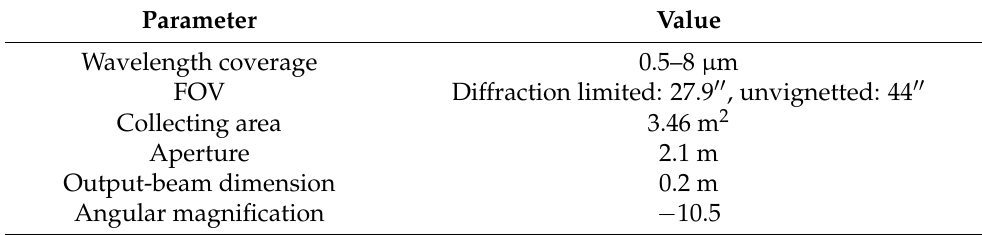
Table 6. Optical-design parameters of telescope.